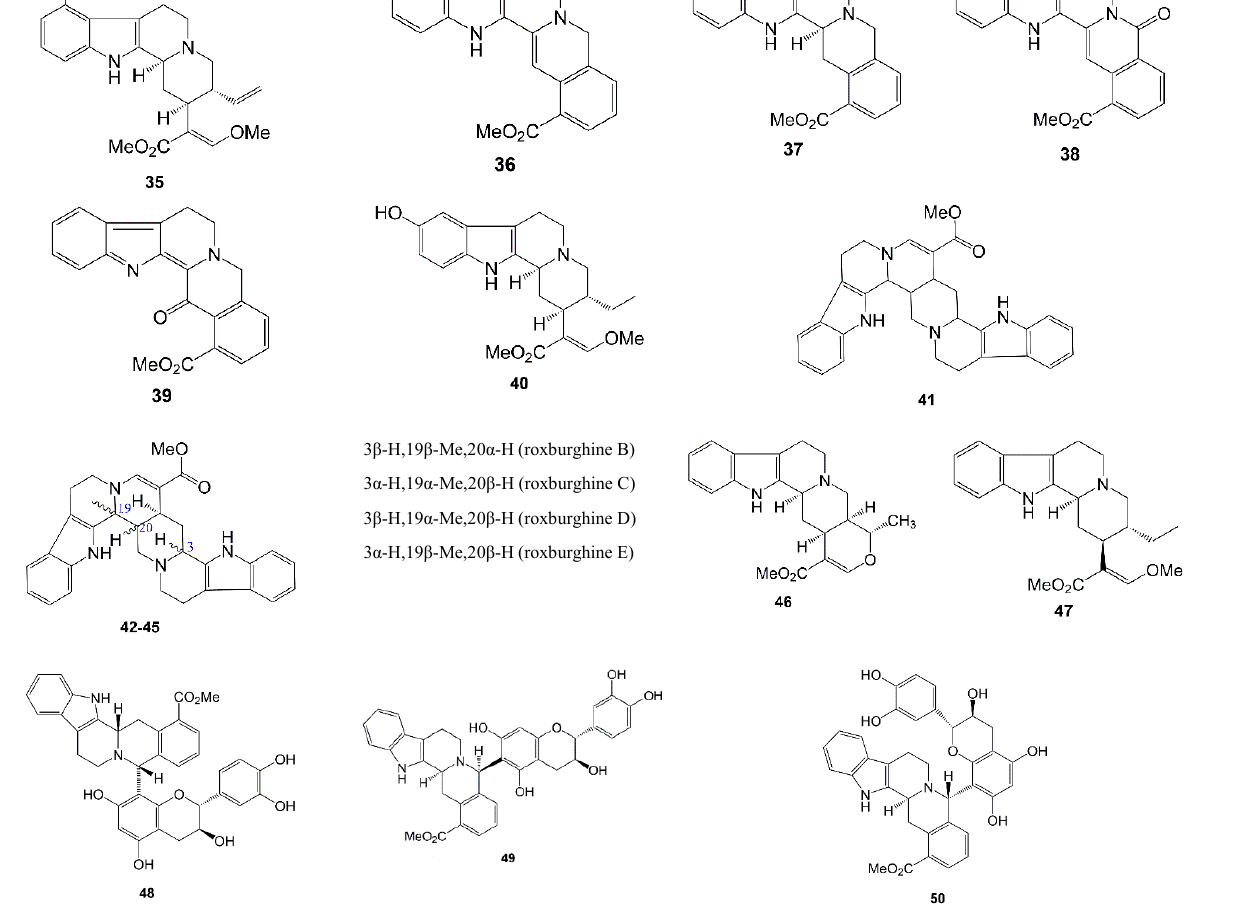
Figure 5. Chemical structure of alkaloid ( 35 – 47 ) and dimeric catechin-alkaloid compounds ( 48 – 50 ) from Uncharia gambir Roxb.